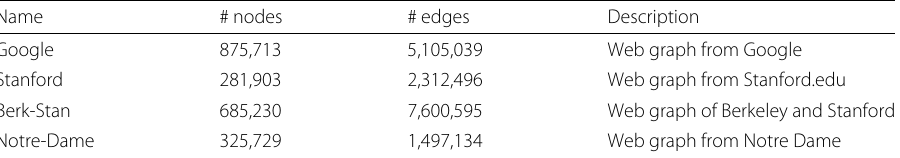
Table 2 Basic statistics of the web graphs